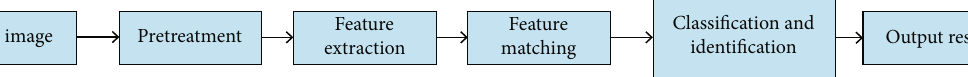
Figure 2: The traditional lip print recognition fl ow.